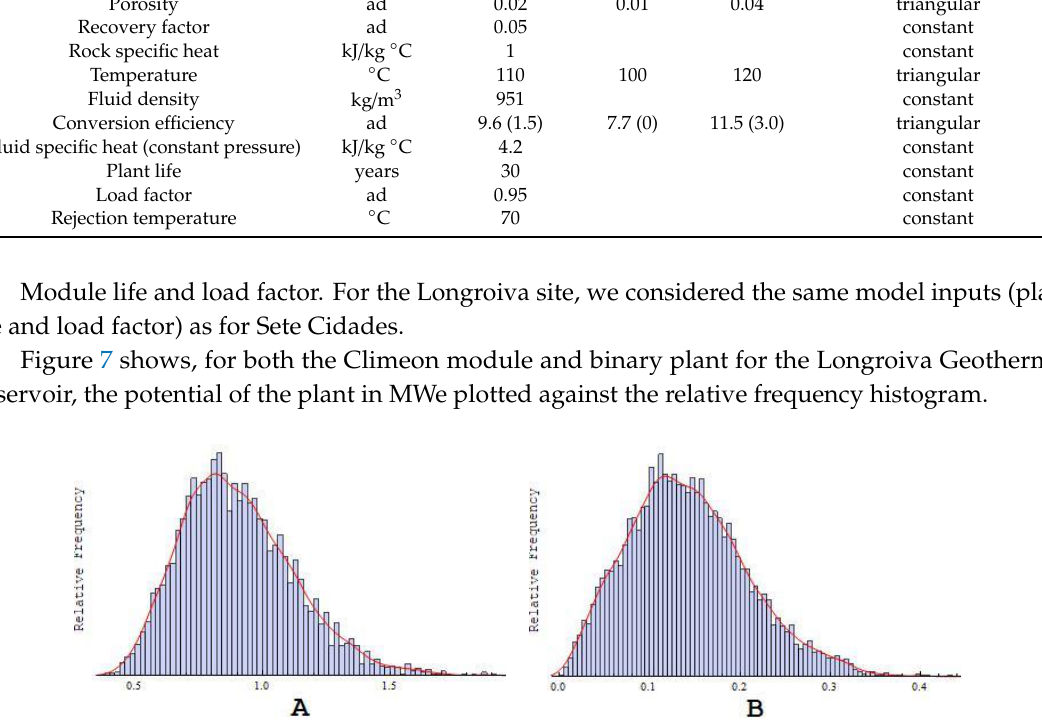
Figure 7. The histogram shows the power capacity of the Longroiva Hydrothermal Reservoir according to the data in Table 1. ( A ) Climeon module; ( B ) binary power plants ( x -axis in MWe).